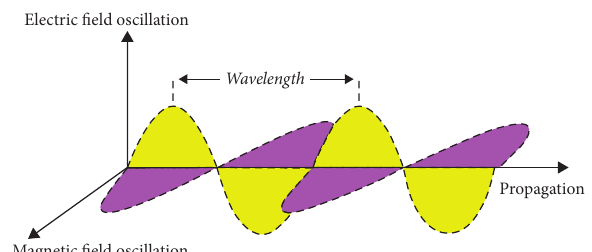
Figure 2: This is a common representation of electromagnetic waves. They are particular solutions of Maxwell’s equations, but in practice they occur only for radio waves and higher frequencies. In proximity to power lines and appliances, where only static or low- frequency currents or voltages occur, the electric and magnetic fields do not follow the characteristics given in this figure.